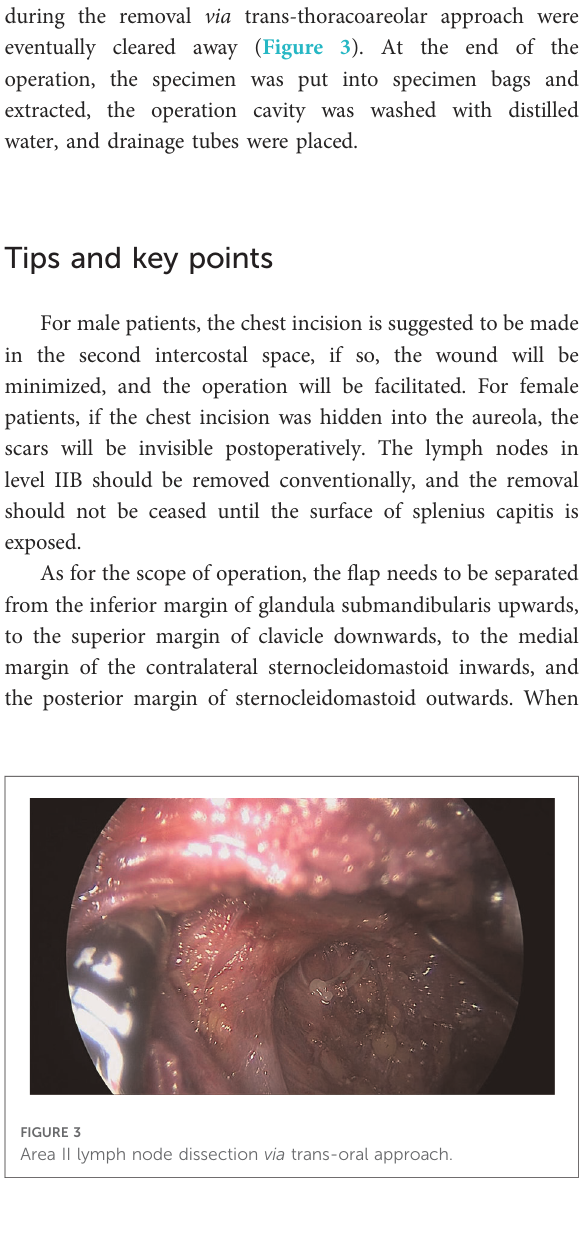
TABLE 2 Endoscopic lateral neck dissection reported by other